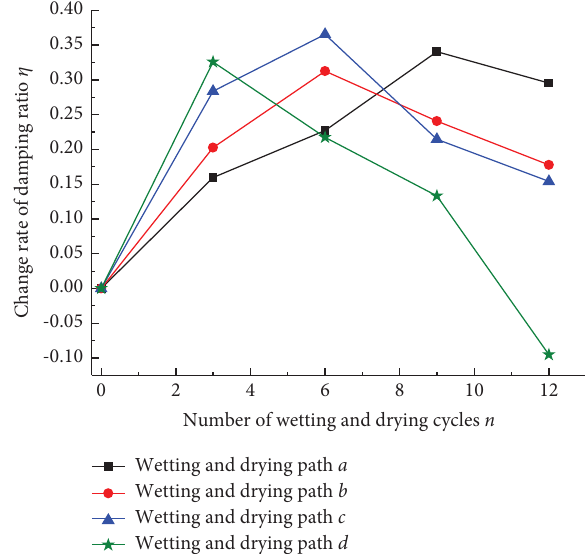
Figure 9: Te relationship between η and n .